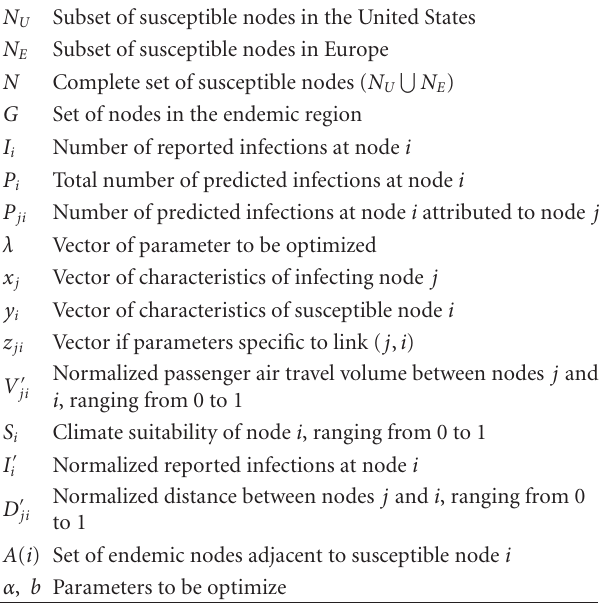
Table 1: Problem